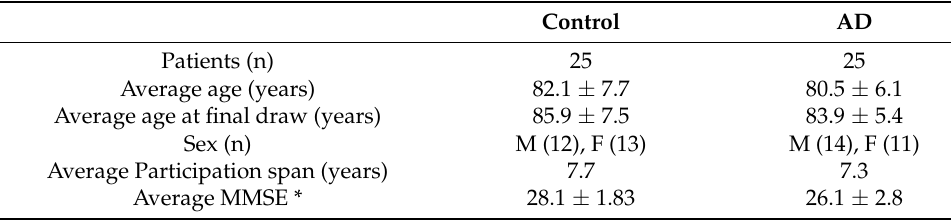
Table 2. Description of patient